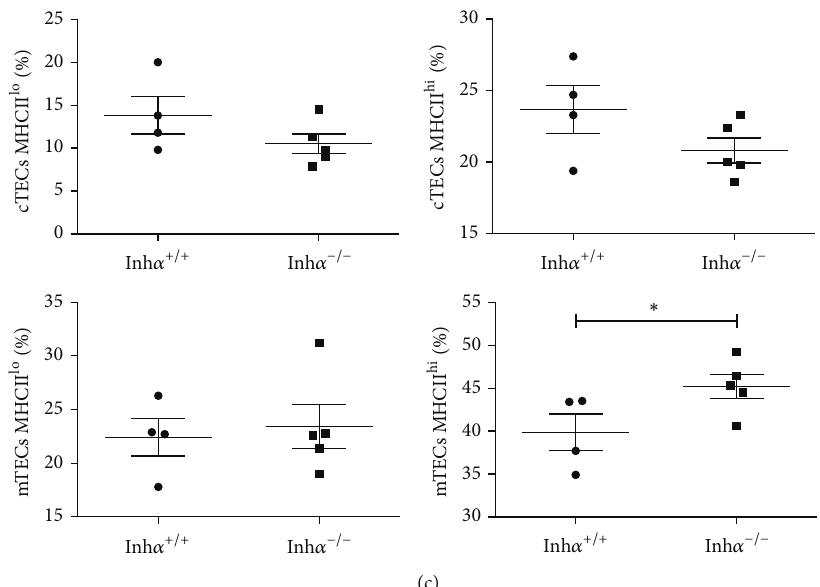
Figure 4: Inh 𝛼 −/− mice show reduced numbers of thymic cTECs and express lower levels of MHCII. (a) The gating scheme to identify thymic epithelial cells is shown. From the CD45-gated subpopulation, Ly51 and MHCII markers are used to identify cortical (Ly51 + MHCII + ) and medullary(Ly51 − MHCII + )epithelialcells.AmongTECsubpopulations,bothcorticalandmedullary,MHCIIexpressionisusedtodistinguish immature (MHCII lo ) and mature TECs (MHCII hi ). Cortical and medullary epithelial cells subsets could be distinguished as Ly51 + MHCII lo / hi and Ly51 − MHCII lo / hi , respectively (a). Dot blot that shows one representative experiment of a total of 9 (Inh 𝛼 +/+ , 𝑛 = 4 ; Inh 𝛼 −/− , 𝑛 = 5 ) mice is shown. (b) The percentage and absolute numbers of total cTECs and mTECs are shown. A significant increase in the percentage of mTECs and a decrease in the percentage of cTECs in Inh 𝛼 −/− compared to Inh 𝛼 +/+ mice. (c) A slight decrease in the percentage of cTEC MHC lo ( 𝑃 = 0.09 ) and cTEC MHCII hi ( 𝑃 = 0.07 ) and a significant increase in the percentage of mTEC hi were detected in Inh 𝛼 −/− compared to Inh 𝛼 +/+ mice. For this analysis, Inh 𝛼 +/+ , 𝑛 = 4 and Inh 𝛼 −/− , 𝑛 = 5 were used. Statistical significance: ∗ 𝑃 ≤ 0.05